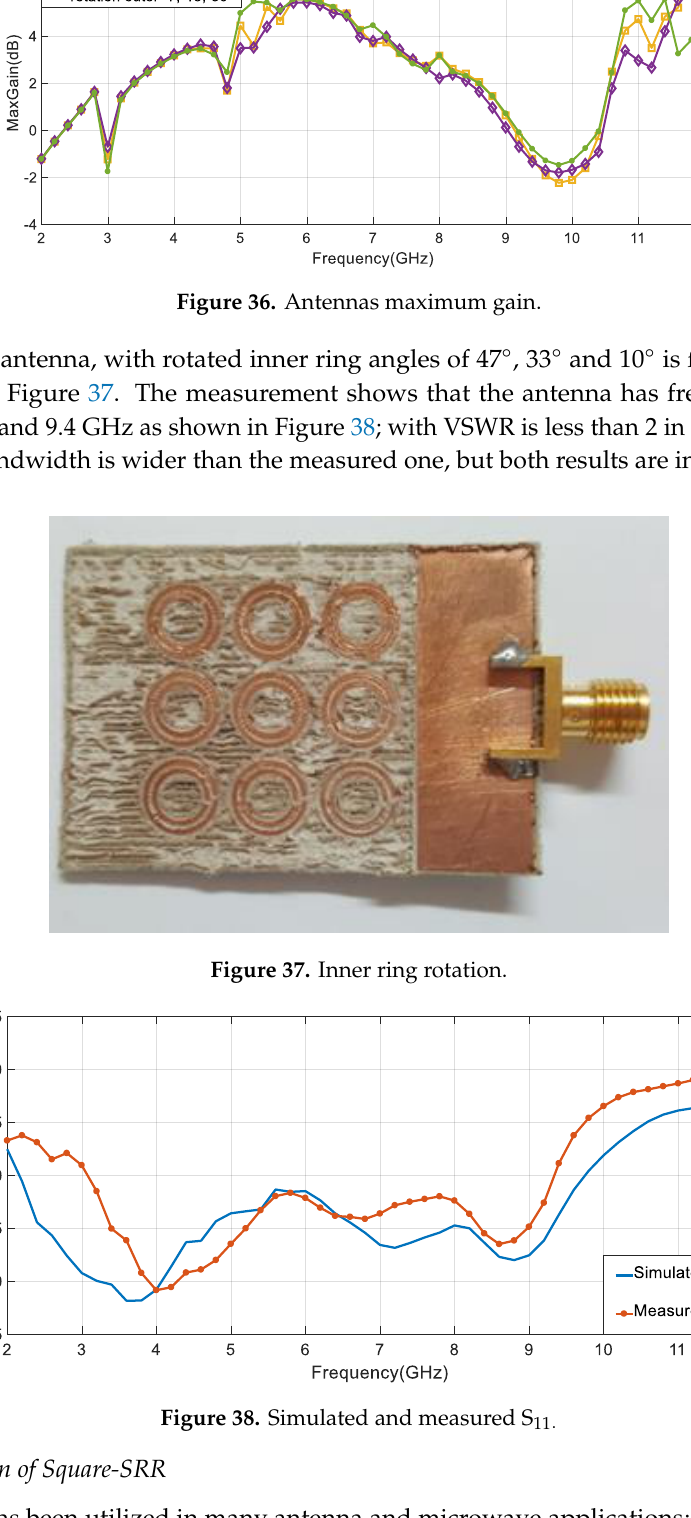
17 of 23 Figure 34. Inner and outer ring rotation for positive and negative angles.